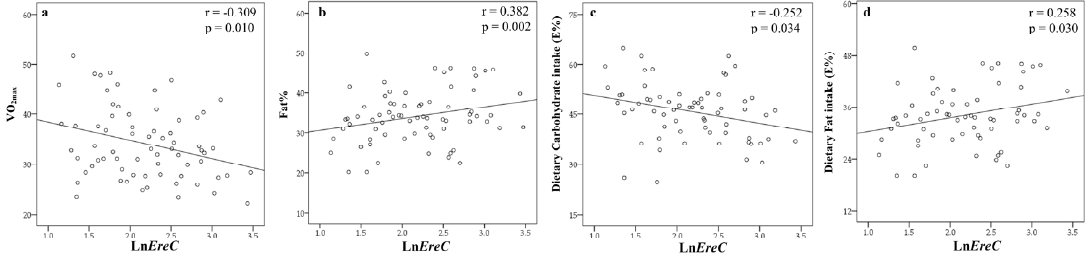
Figure 2. The associations of EreC group with VO 2max , fat%, and energy yield (E%) nutrients. ( a ) EreC was inversely correlated with VO2max; ( b ) EreC was positively correlated with fat%; ( c ) EreC was inversely correlated with carbohydrate intake (E%); ( d ) EreC was positively correlated with fat intake (E%). Ln = log transferred values; EreC = Eubacterium rectale-Clostridium coccoides .